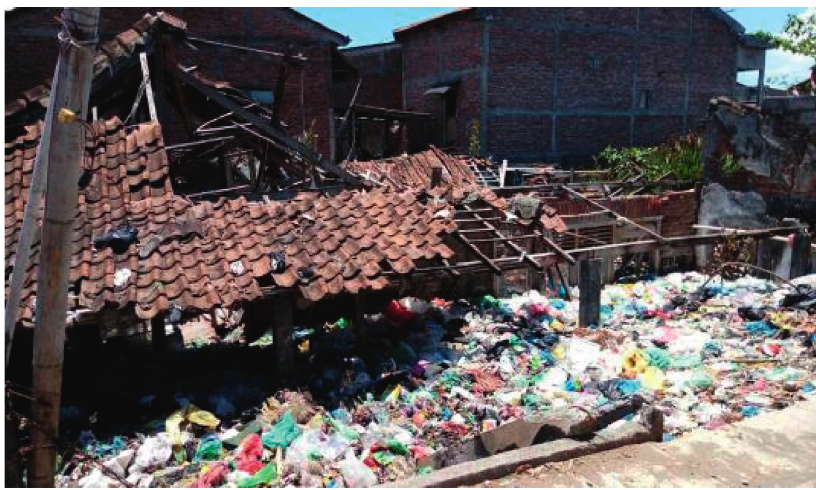
Figure 1: Plastic waste accumulation in Tambak Lorok coastal area, Semarang, Indonesia